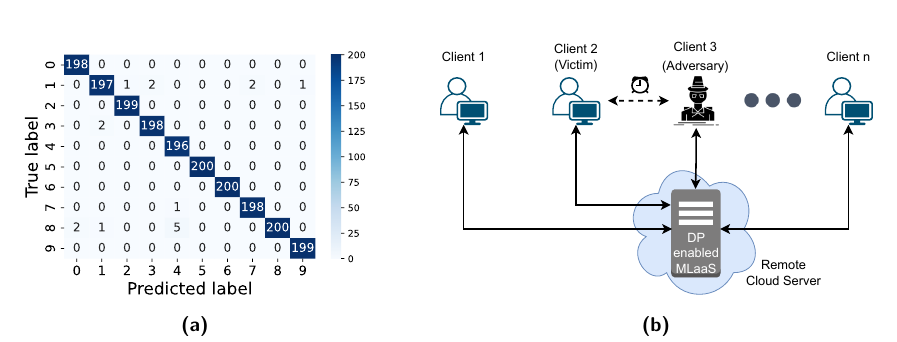
Figure 10: (a) Confusion Matrix for timing test data on the MLP model with timing values from custom CNN trained with DP (b) Threat Model for Privacy Violation in DP